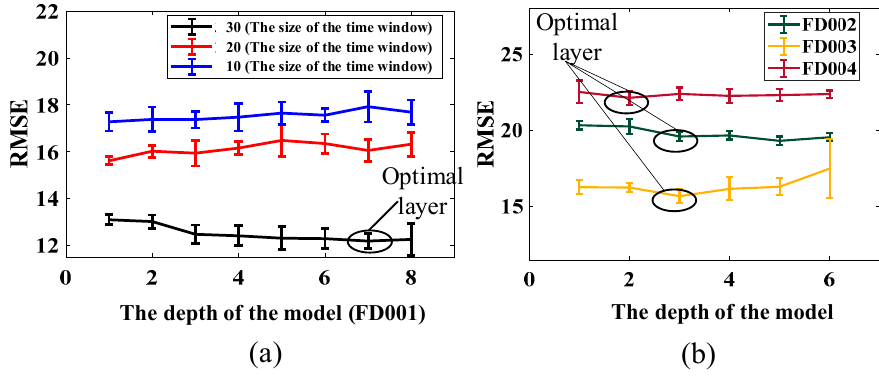
Figure 9. Prediction results: ( a ) FD001;( b ) FD002, FD003 and FD004.